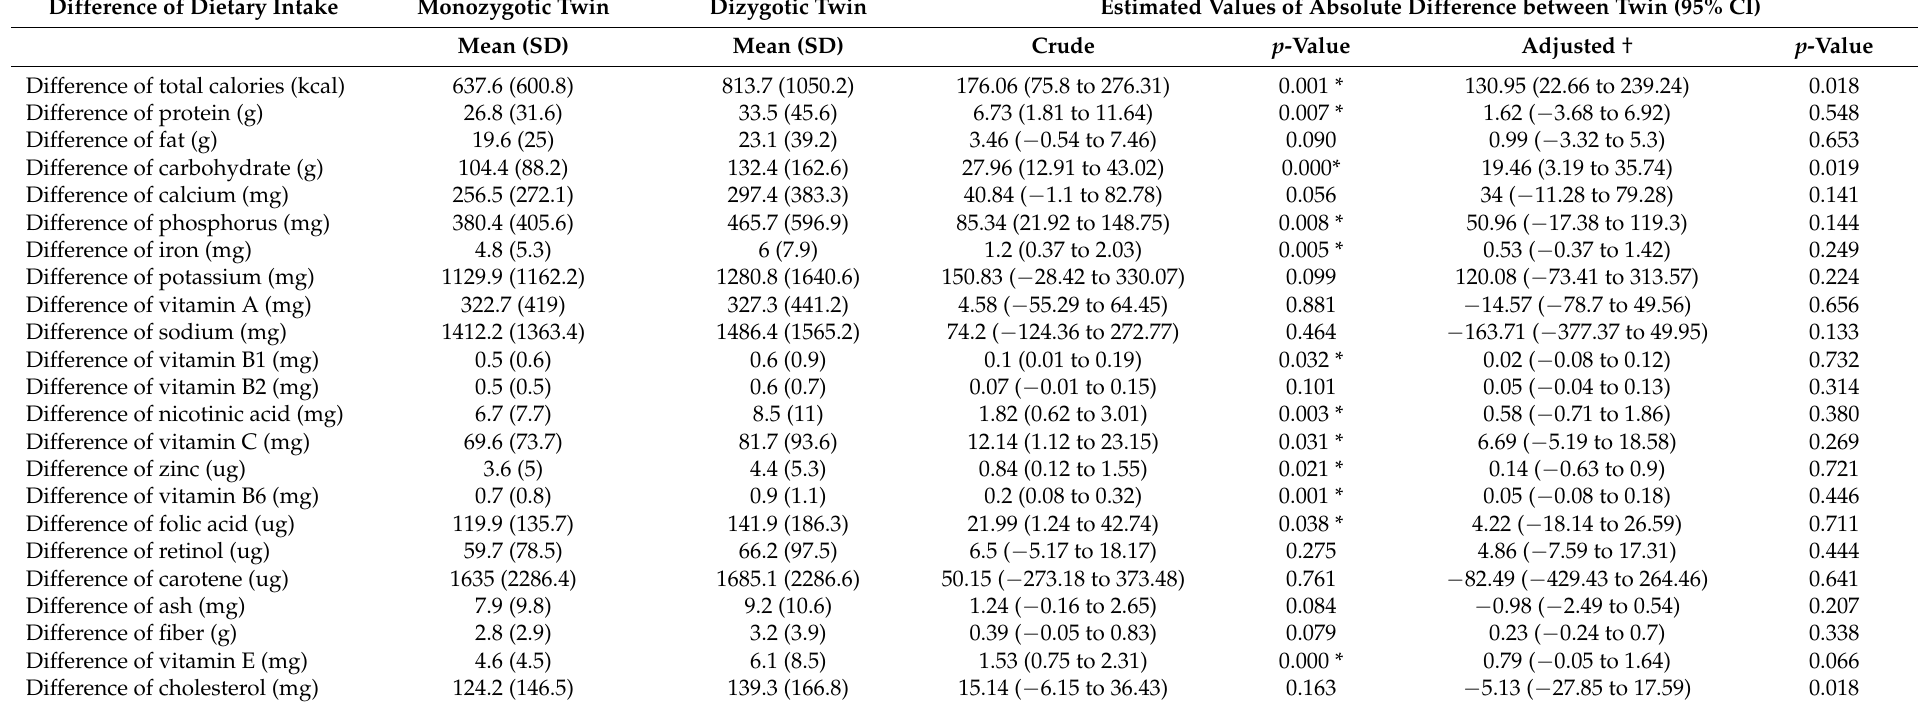
Table 2. Estimated values of nutritional